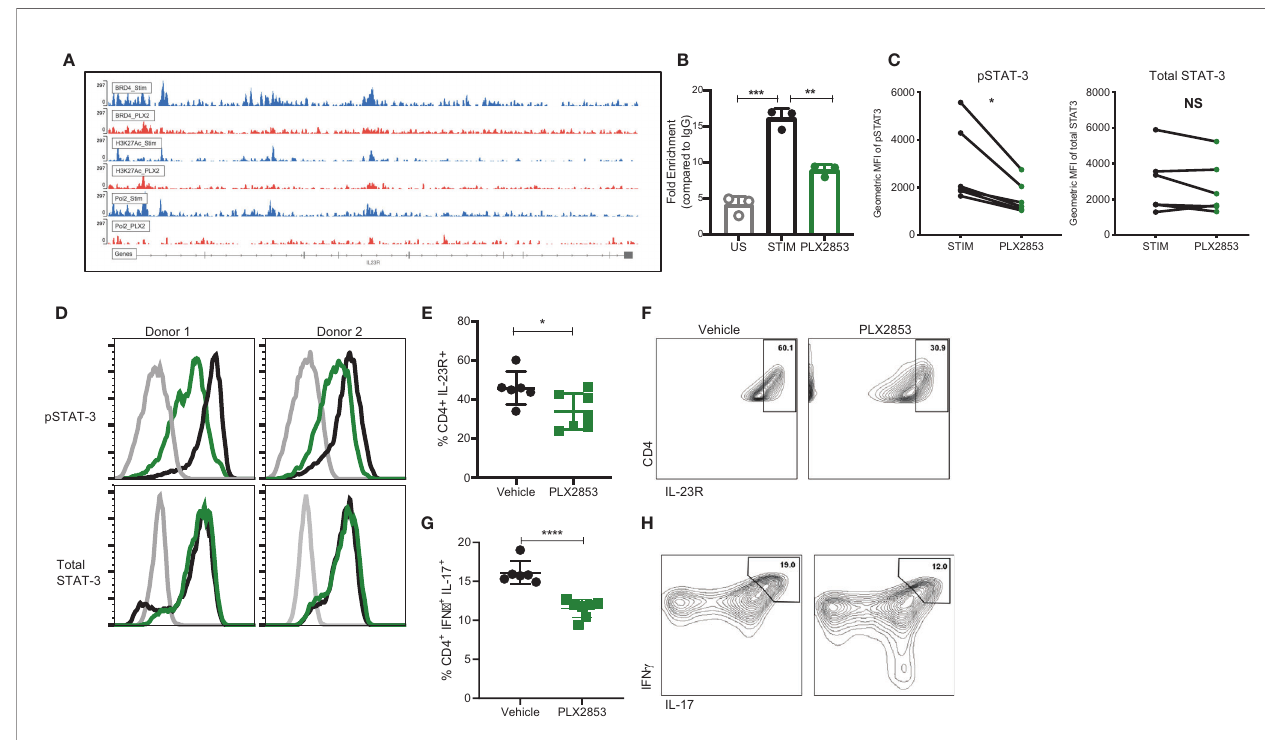
FIGURE 6 | BET inhibition modulates IL-23R/STAT3 axis. (A) Healthy human donor (HD) T cells were stimulated with CD3/CD28 for 24 hours in the presence or absence of 10 nM PLX2853. ChIP-sequencing peaks for IL-23R gene. (B) ChIP DNA was ampli fi ed with real-time qPCR using SYBR Green. Input standard curves were used for estimation of relative enrichment. (C) Healthy donor human PBMCs (n=6) were stimulated with CD3/CD28 for 48 hrs ± PLX2853 (10nM, green). Cells were starved for 4 hrs and then pulsed with IL-23 for 15 min, phosphorylated and total STAT3 expression analyzed by fl ow cytometry. Geometric mean fl uorescence intensity (MFI) of phospho- and total STAT3. (D) Histogram of two representative donors showing unstimulated (gray), CD3/CD28 stim +IL-23 pulse (black), CD3/ CD28 stim + PLX2853 + IL-23 pulse (green). (E – H) B6 into B6D2F1 transplant was performed as described earlier and recipients of allogeneic splenocytes were treated with vehicle or PLX2853. Small intestine of the GI tract was harvested from mice as described in methods (n=6 per cohort). (E) Percentage and (F) contour plots of IL-23R+ CD4+ and (G) Percentage and (H) contour plots of IFN g + IL-17+ CD4+ T cells as determined by fl ow cytometric analysis. *p < 0.05, **p < 0.01, ***p < 0.001, ****p < 0.0001. Data shown is representative of one of two independent transplant experiments. NS, not signi fi